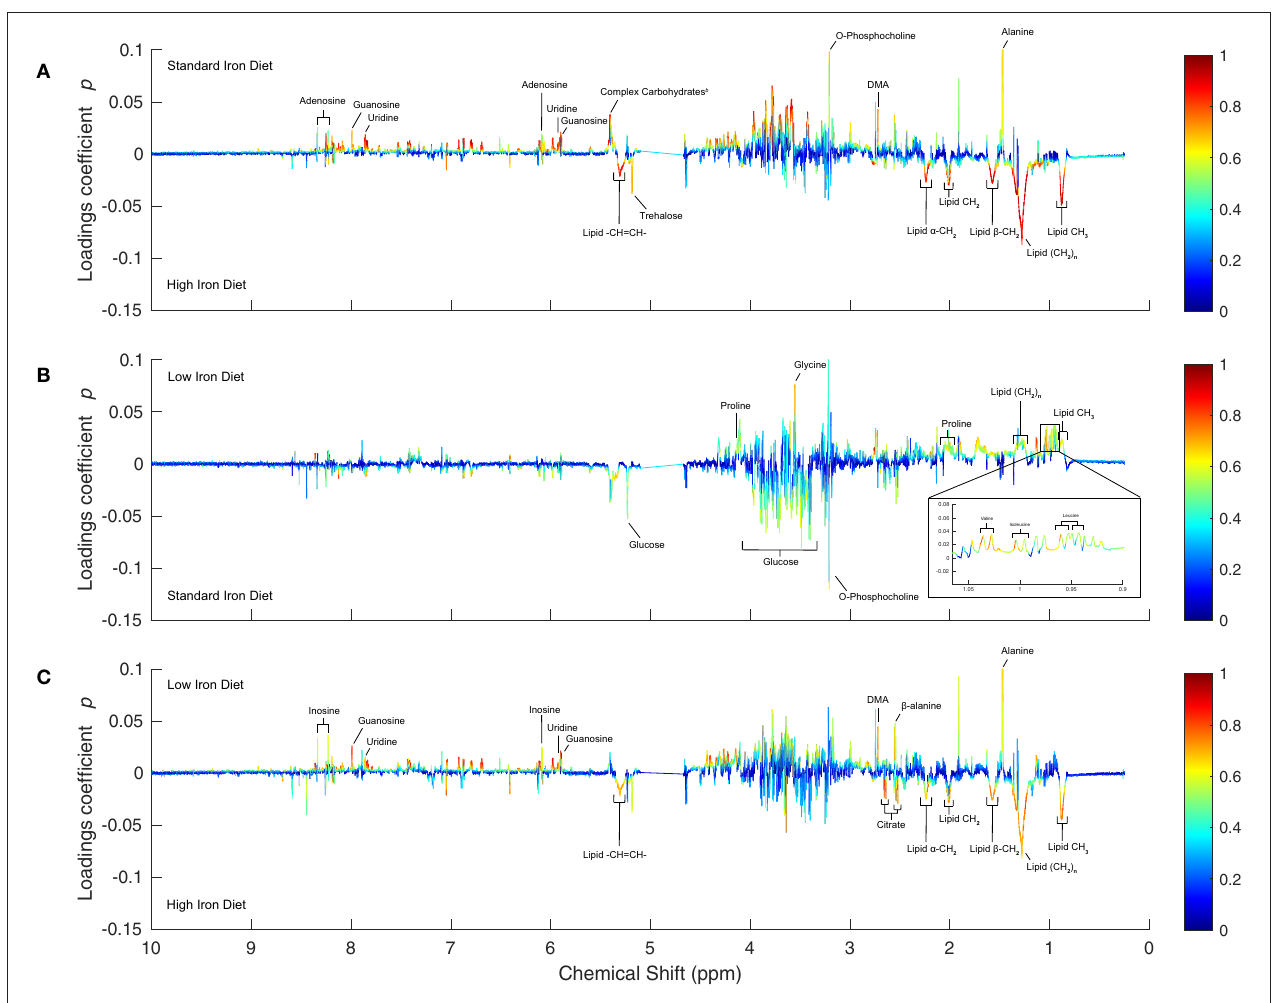
FIGURE 3 | OPLS 1D S-Plots of the pairwise diet comparisons for uninfected controls. (A–C) The 1D S-plots are analogous to Figure 2 , but show the diet comparisons for uninfected controls. The significantly altered metabolites ( | p | ≥ 0.015 & | p ( corr )| ≥ 0.6) are annotated in each panel: (A) High- v. standard-iron diet (model M8 ), (B) Standard- v. low-iron diet (model M9 ), and (C) High- v. low-iron diet (model M10